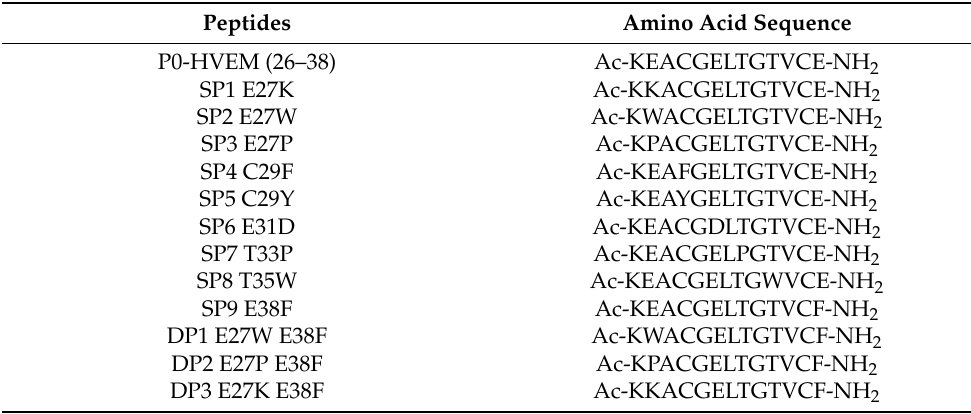
Table 1. Sequences of HVEM (26–38) mutants for